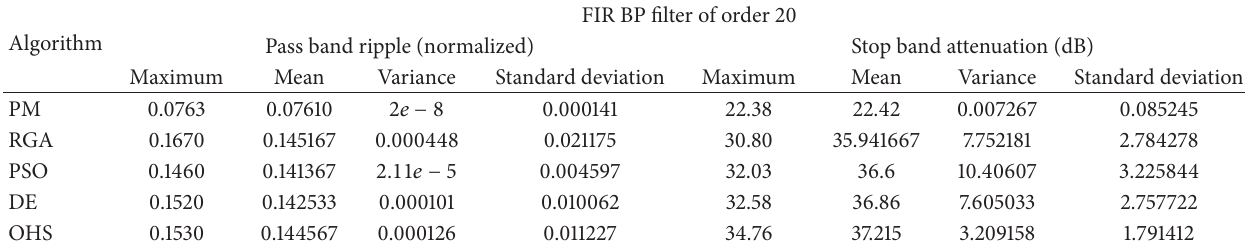
Table 13: Statistical parameters of FIR BP filters for different